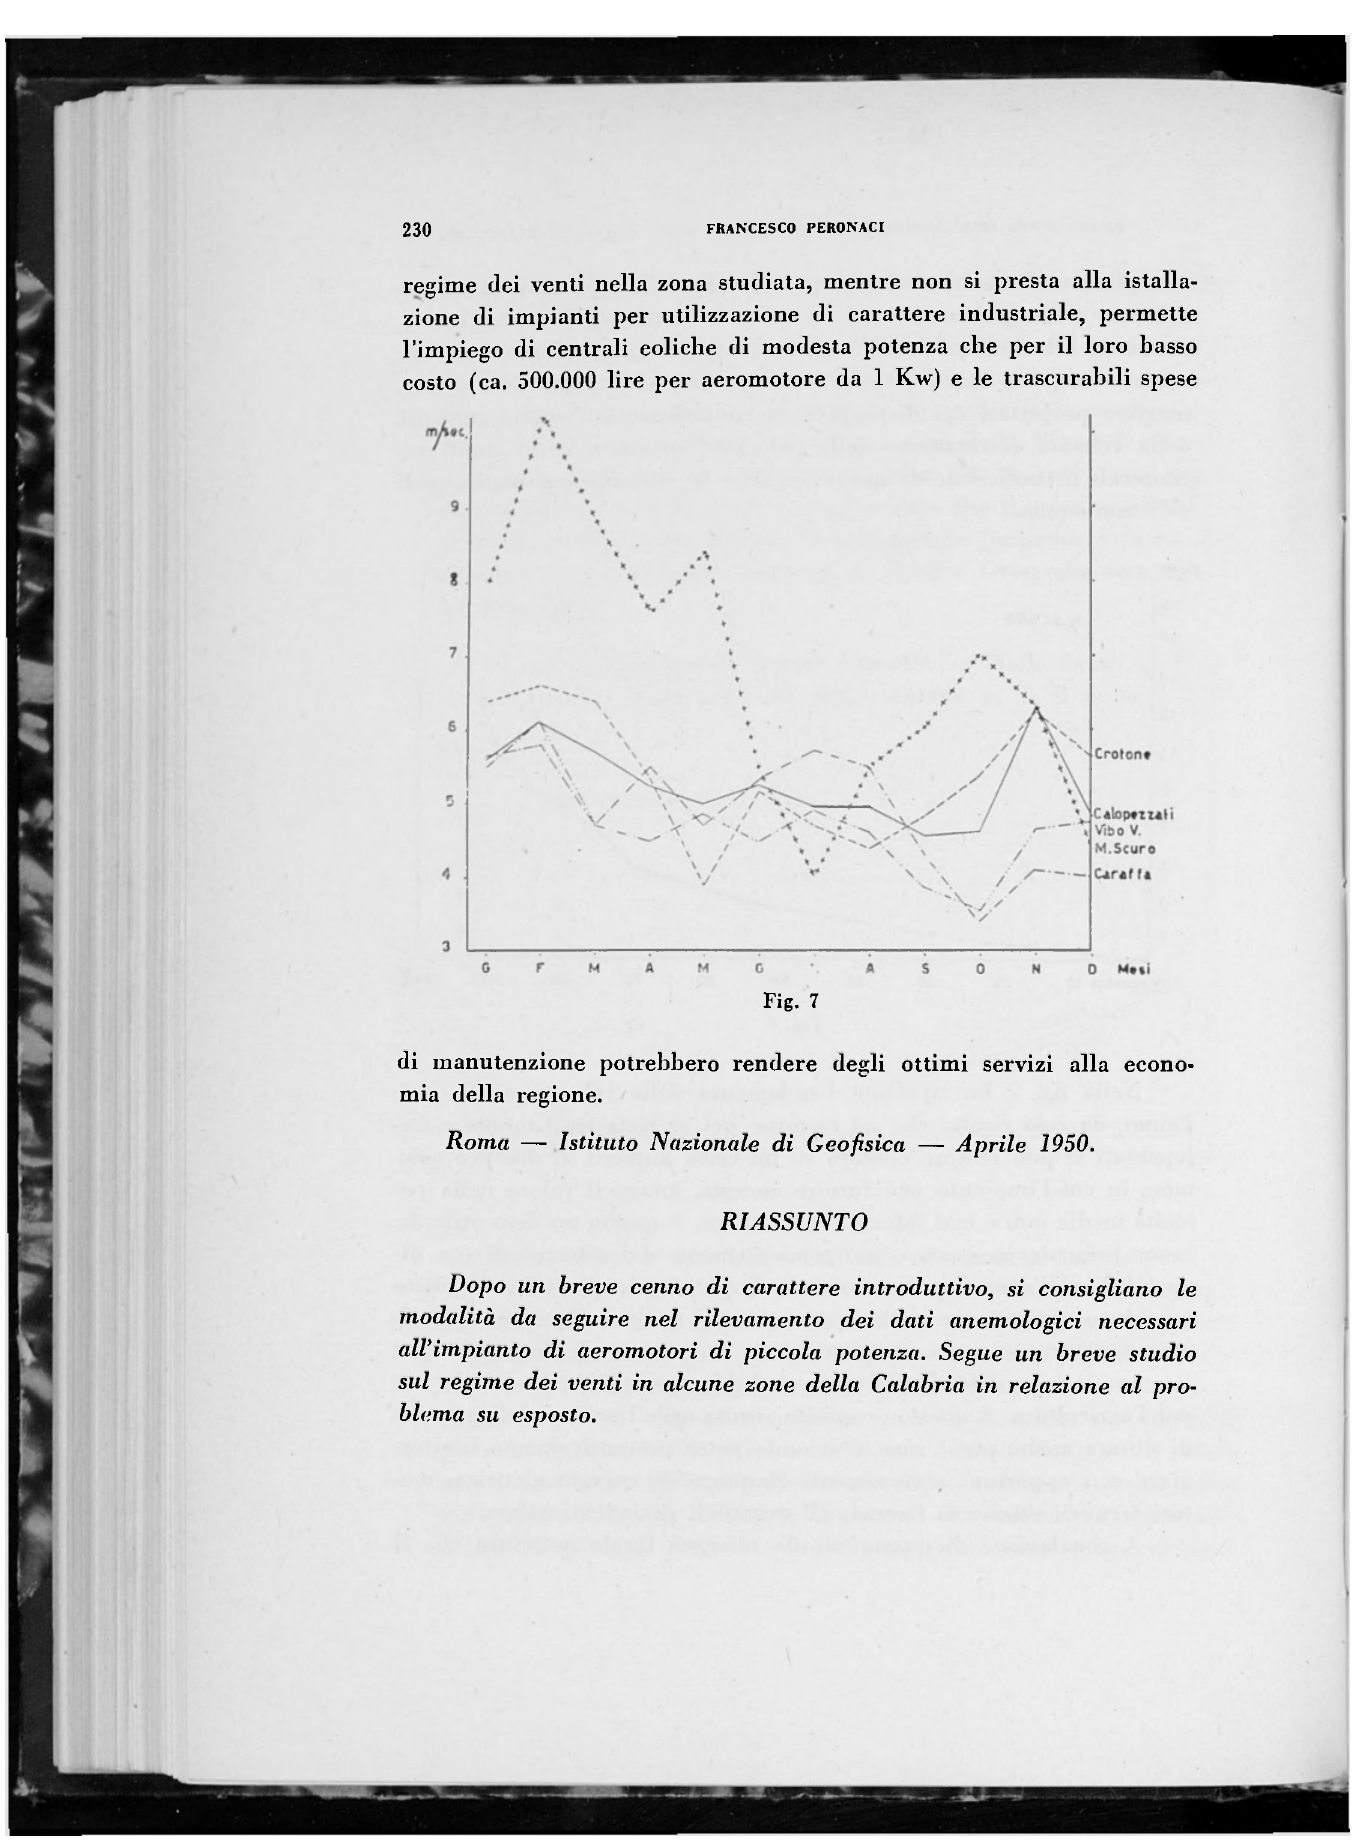
di manutenzione potrebbero rendere degli ottimi servizi alla econo- mia della